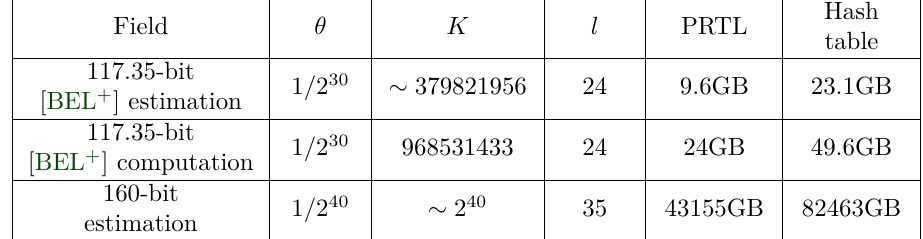
Table 6: Memory requirements of large ECDLP computations using PRTLs and hash